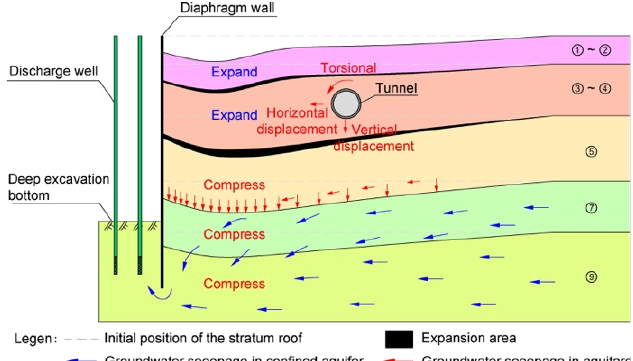
Figure 11. Conceptual schema of stratified settlement in strata around the tunnel.